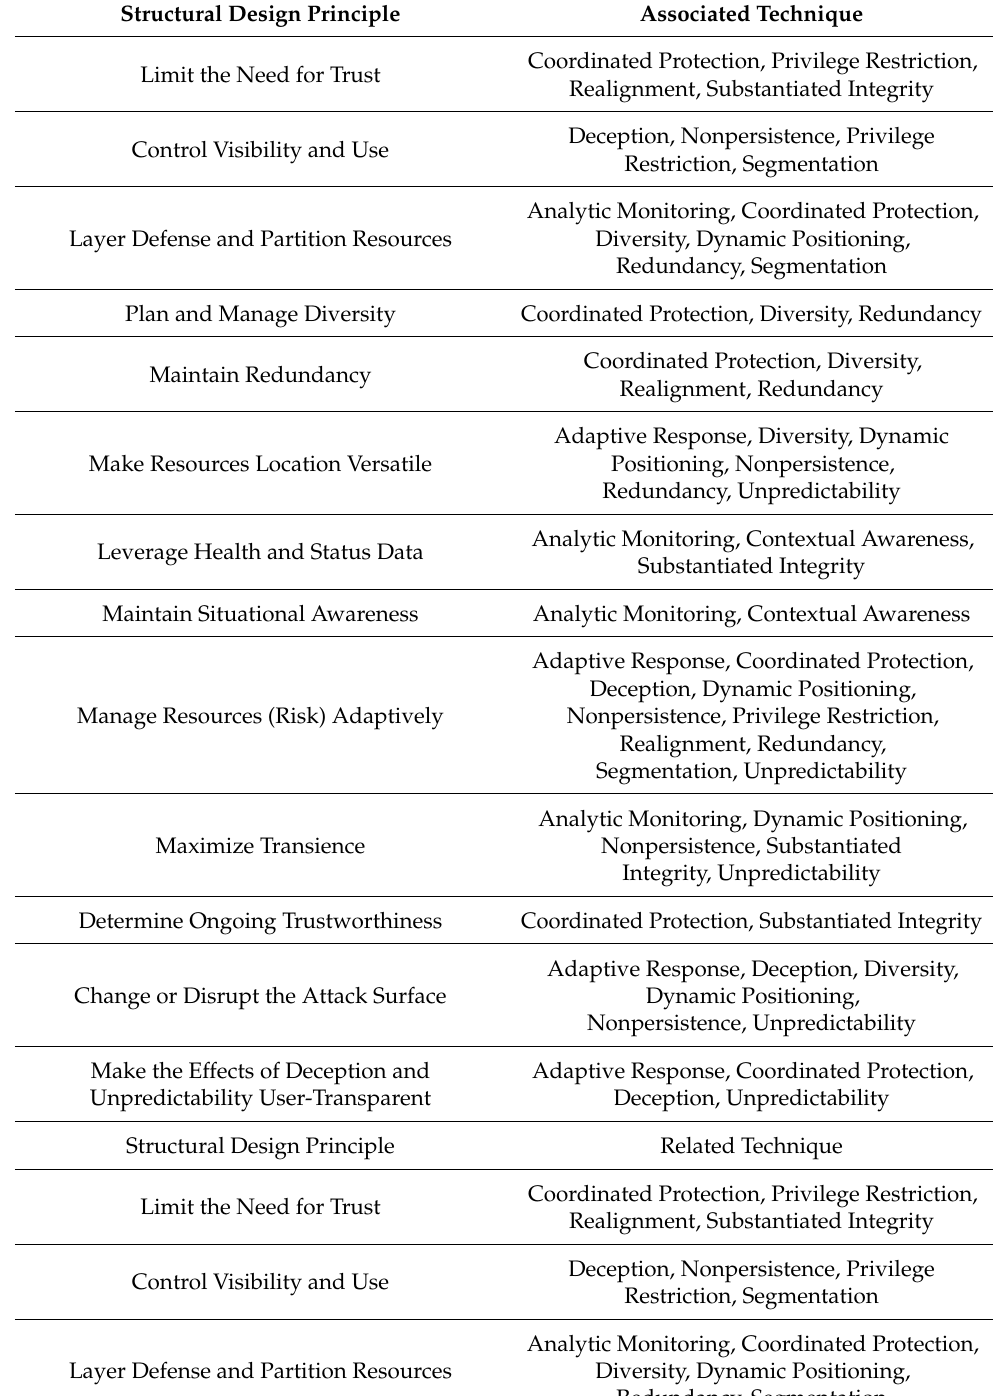
Table 4. NIST 800-160 Vol. 2 Table D-15: cyber resiliency structural design principles and associated implementation techniques